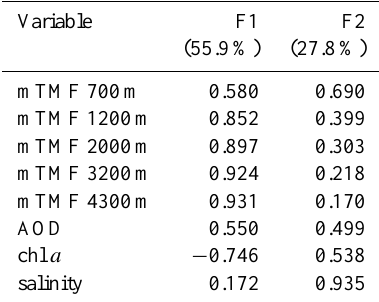
Table 3. Factor loadings after Varimax rotation. Variable